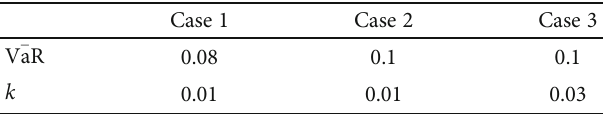
Table 2: VaR control levels and levels with time interval h = 1/250